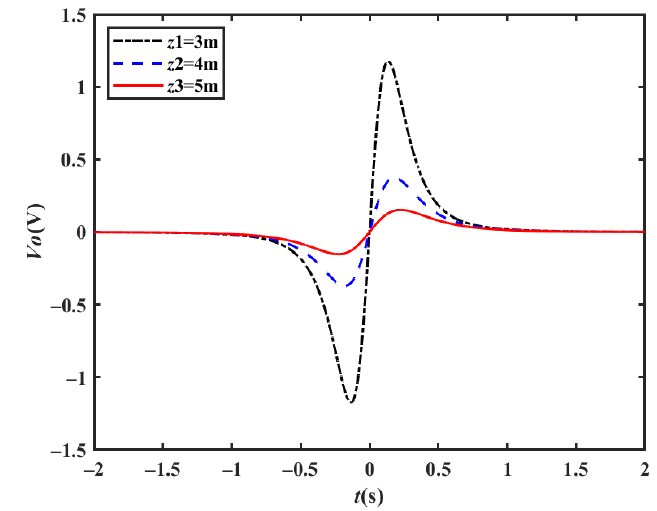
Figure 5. Simulation output waveforms at different detection distances ( v = 40 km/h).